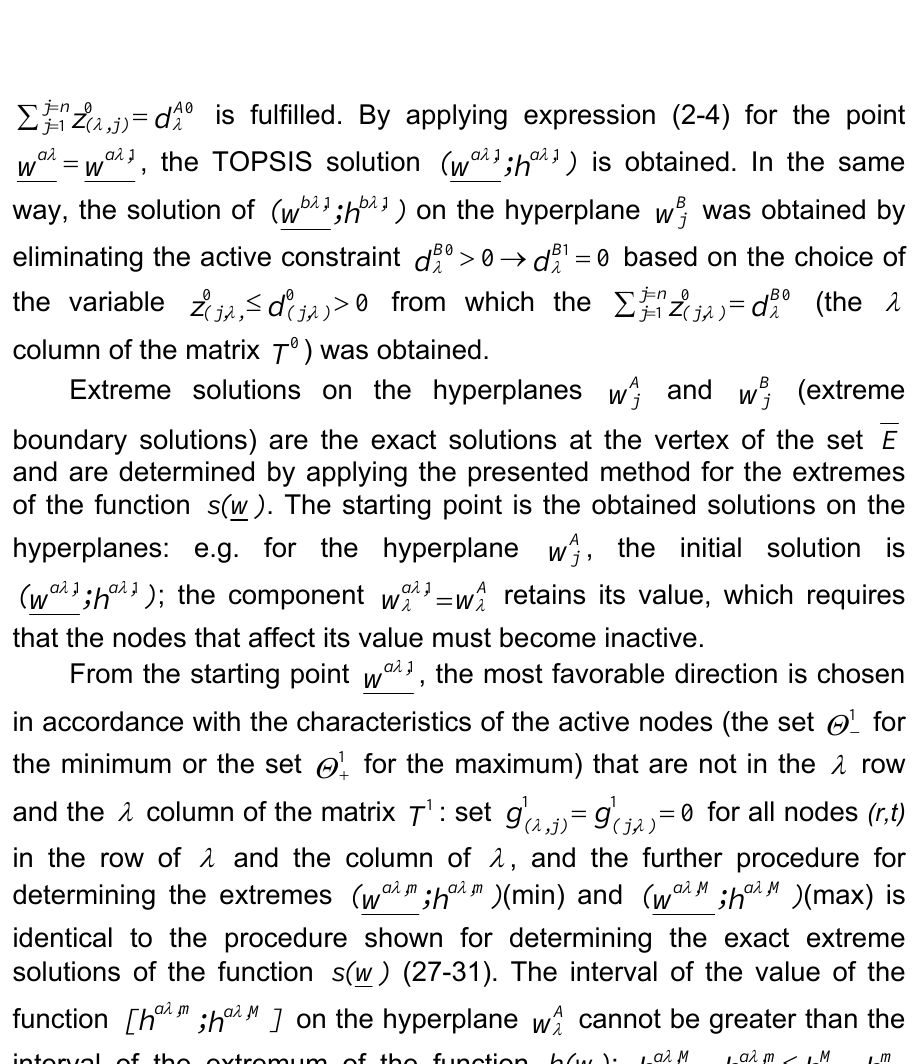
Figure 2. In the same way, the extreme solutions on the hyperplane w B are determined. Extreme boundary solutions (maximum 4n solutions), among which are the extreme solutions )w(h of the function, are unique in terms of the corresponding points w and the values of the function )w(h . Not all extreme points ( w m,a  and w M,a  ) are linearly independent; by eliminating the linearly dependent points, a set of points w v is obtained which are the vertices of the set E